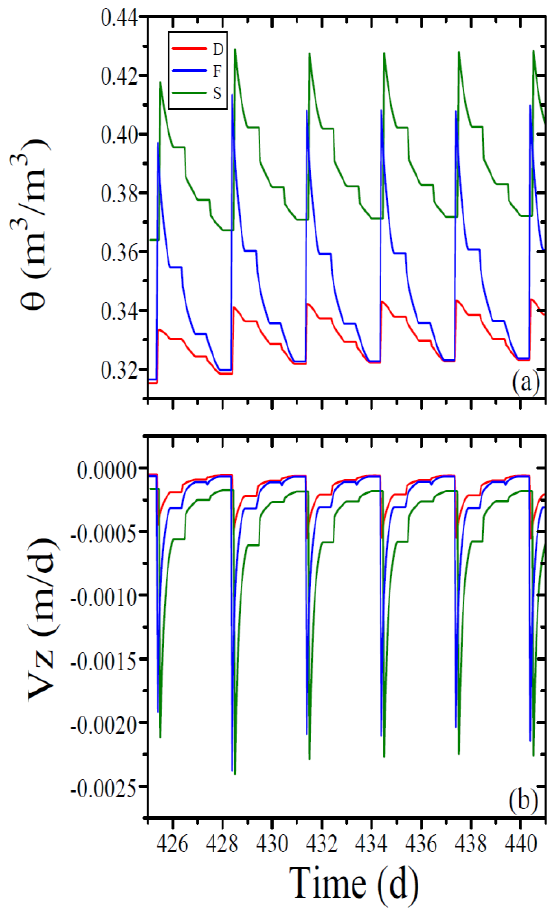
Figure 2. ( a ) Temporal variations of the simulated soil water content, θ, and ( b ) vertical component of the velocity vector, Vz, at soil depth x 1 = Zup, representing the vertical position of the centroid of the soil volume active in water uptake, for the different scenarios examined. Results are depicted for the irrigation season of the second year.